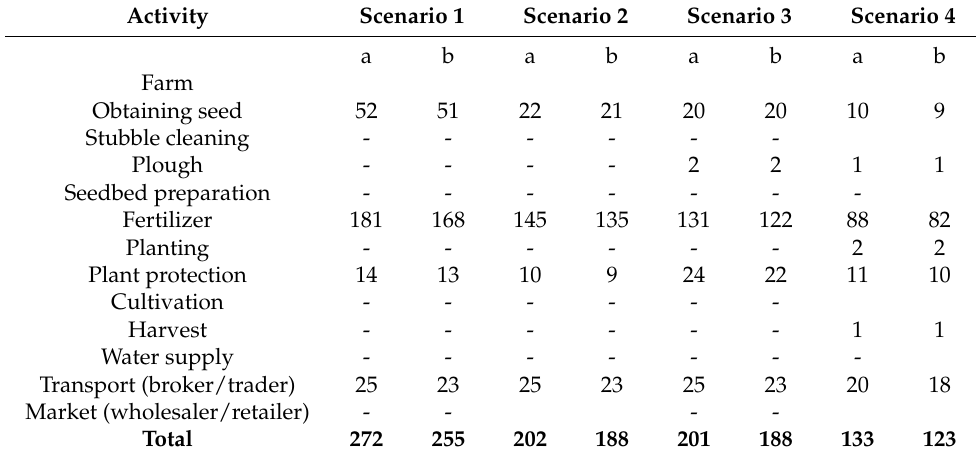
Table 10. Final Results on GHG Emissions (kg CO 2 -eq) per Scenario for Production of 1 ton of Marketable